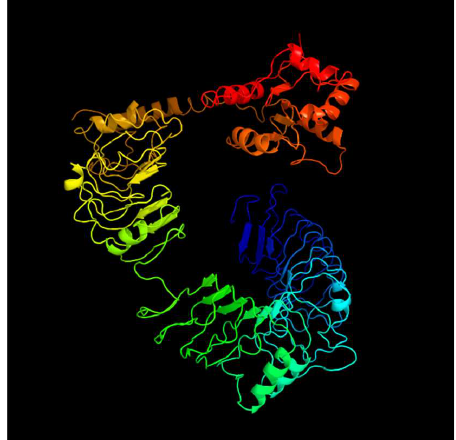
Figure 7. Predicted tertiary structure of tlr14.